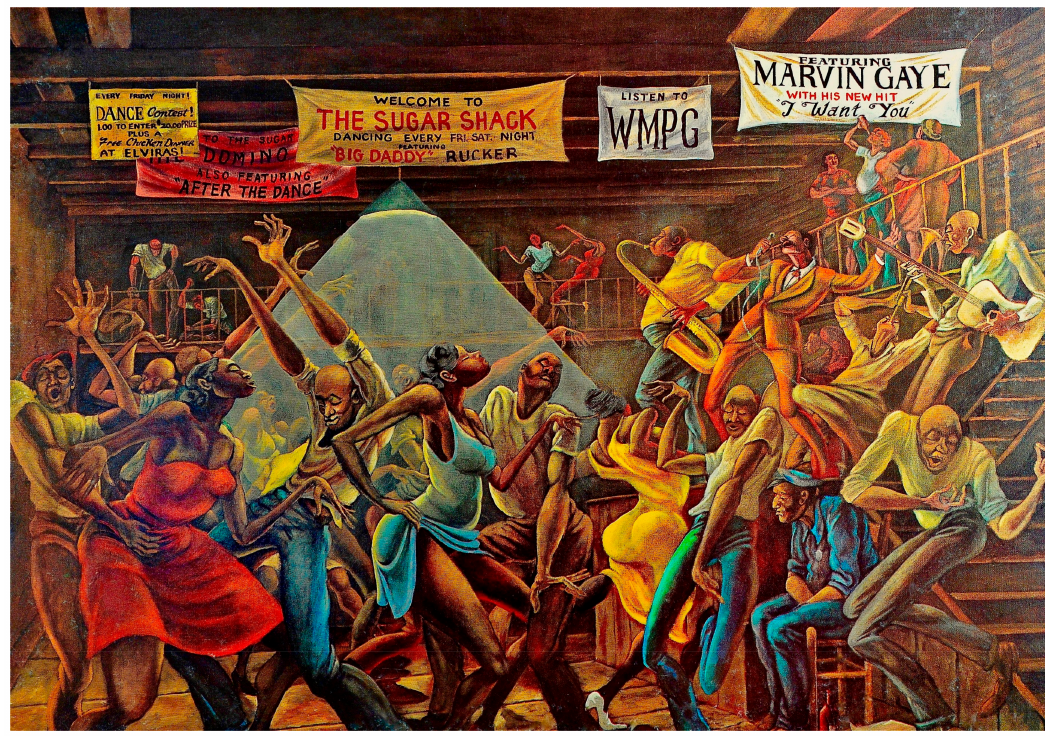
Figure 1. “The Sugar Shack” by Ernie